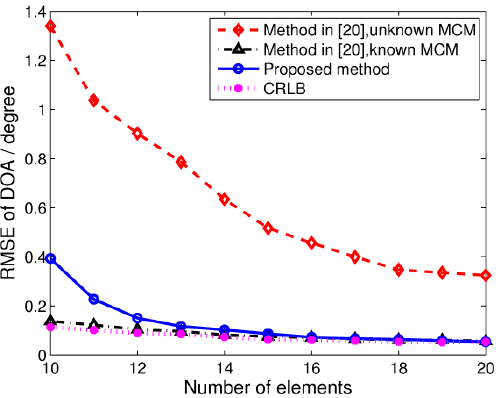
Figure 4. RMSE of DOA estimation versus the number of array elements. SNR = 5 dB, snapshots = 100.